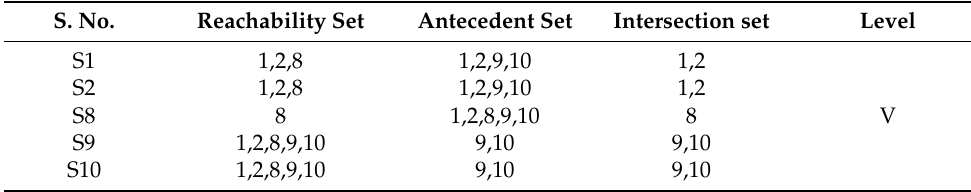
Table A5. Level partitions (Iteration V).